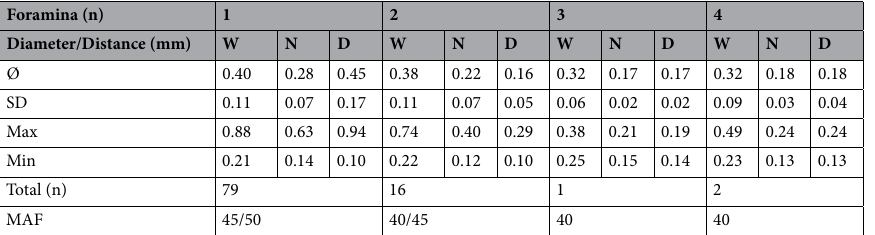
Table 4. Statistical description of the physiological foramen diameter dimensions (mm) and distances between the anatomical and physiological foramen in single-rooted mandibular canines (n = 98) and final preparation size (master apical file [MAF]; ISO instrument tip diameter) recommendations (W = wide diameter; N = narrow diameter, D = Distance between physiological foramen and anatomical foramen; SD = standard deviation).